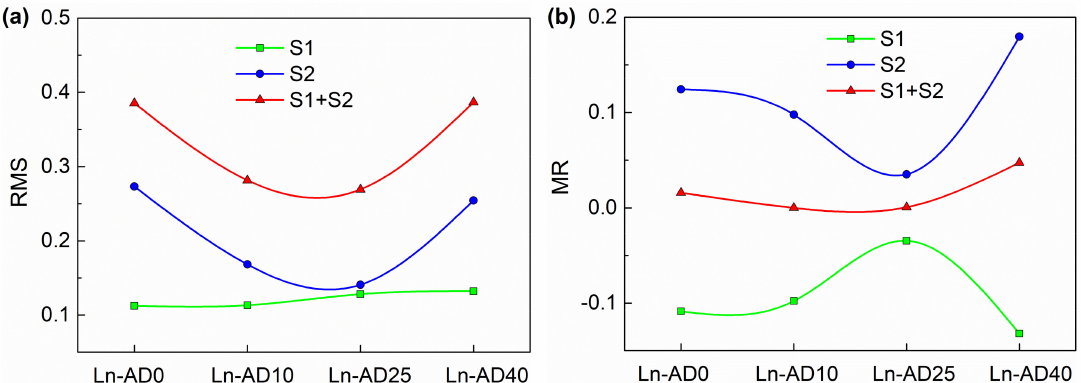
Figure 5. ( a ) RMS and ( b ) MR of co-pyrolysis and gasification of lignite and digestate with di ff erent AD